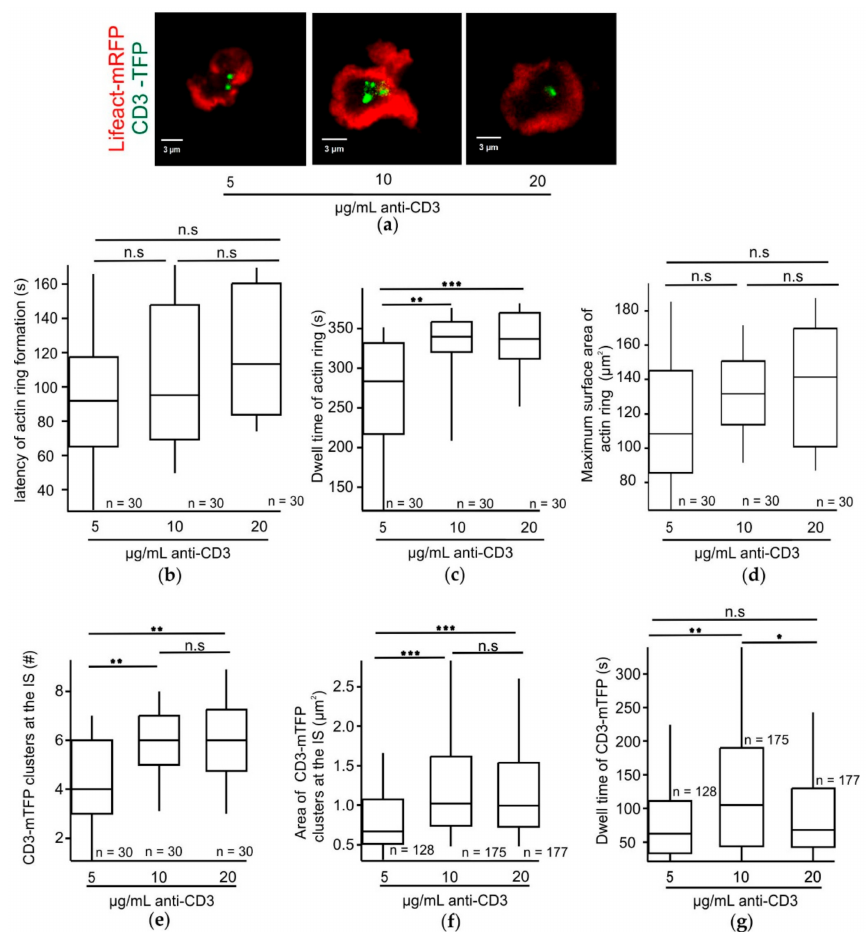
Figure 3. The dwell time of actin rings proportionally increases with the strength of the TCR stimulus, but the dwell time of CD3-mTFP clusters at the immune synapse (IS) requires an optimum TCR stimulus in an effector CTL synapse. ( a ) CTLs expressing Lifeact-mRFP (red) and CD3-mTFP (green) adhered to form an IS with varying anti-CD3 concentrations as trigger. Box plots depicting ( b ) latency of actin ring formation, ( c ) dwell time of actin ring, and ( d ) maximum surface area of dSMAC formed. n = number of cells analyzed for each concentration of anti-CD3 stimulus. Box plots depicting ( e ) number of CD3-mTFP clusters where n = number of cells analyzed, ( f ) average area, and ( g ) dwell time of CD3-mTFP clusters. n = number of CD3 clusters analyzed. * p < 0.05; ** p < 0.01; *** p < 0.001; ns, non-significant ( p >